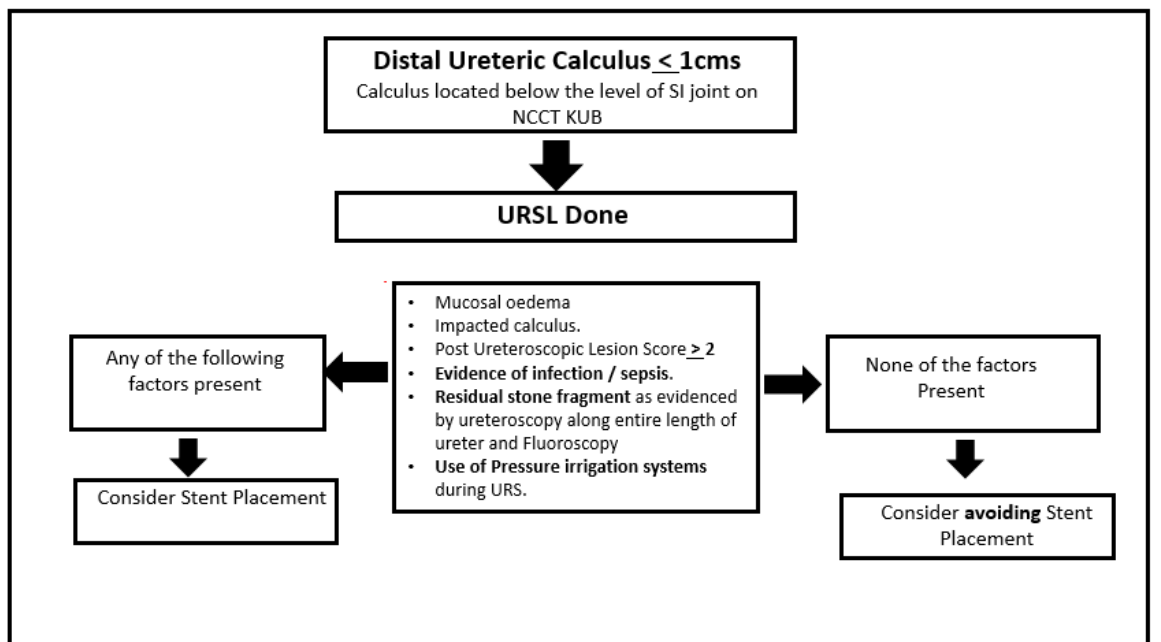
Figure 3. Algorithm proposed regarding the placement of stents after uncomplicated URS.